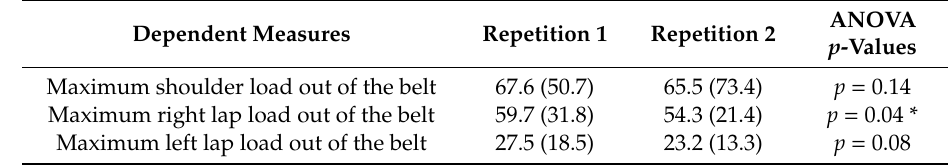
Table 7. Mean (SD) of maximum seat belt load: e ff ect of